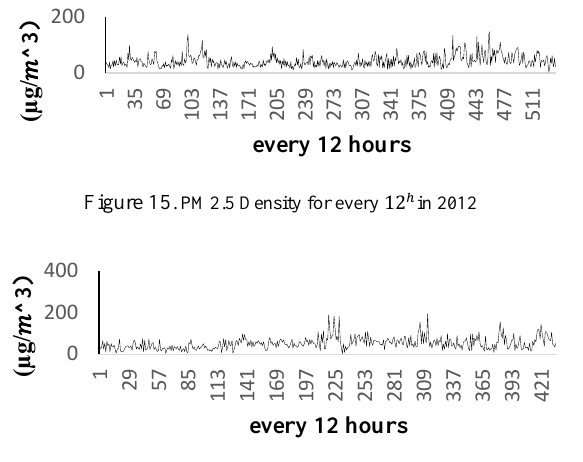
Figure 16 . PM2.5 Density for every 12 ℎ in 2013